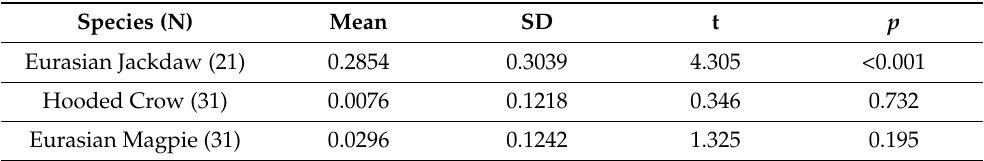
Table 2. Changes in the average growth rate ( λ ) of the three corvid species during 1991–2020 in Finland. Test of lambda against the zero-growth rate (one-sample t -test and test value = 0) in three wintering corvid species in Finland. Species